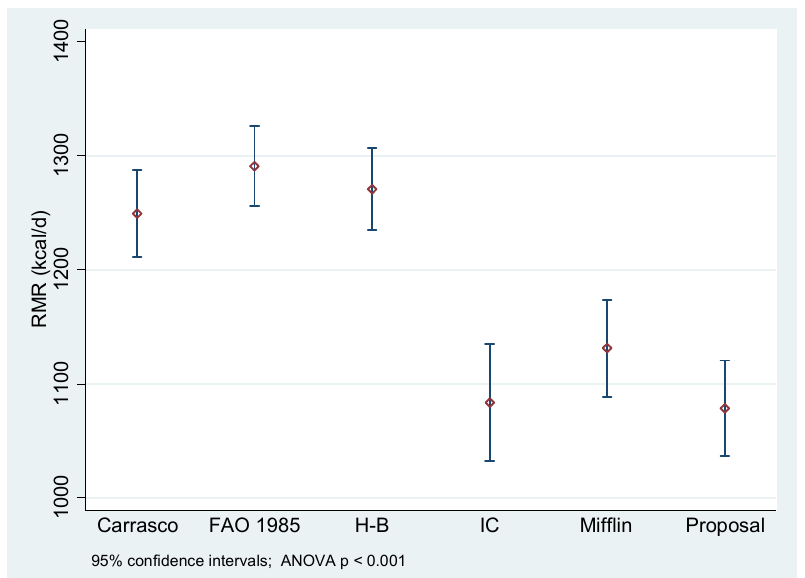
Figure 1. Resting metabolic rate measured by indirect calorimetry versus estimation by predictive equations in older Chilean women. H-B: Harris–Benedict equation; Mifflin: Mifflin-St Jeor equation; IC: indirect